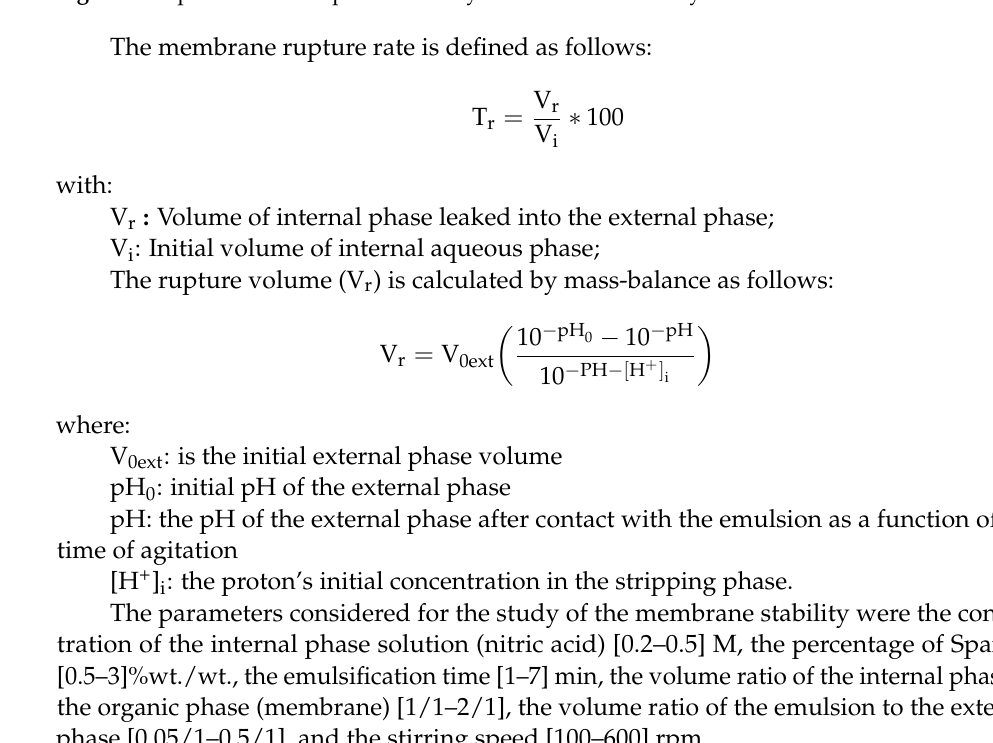
Figure 2. Experimental setup for the study of membrane stability.